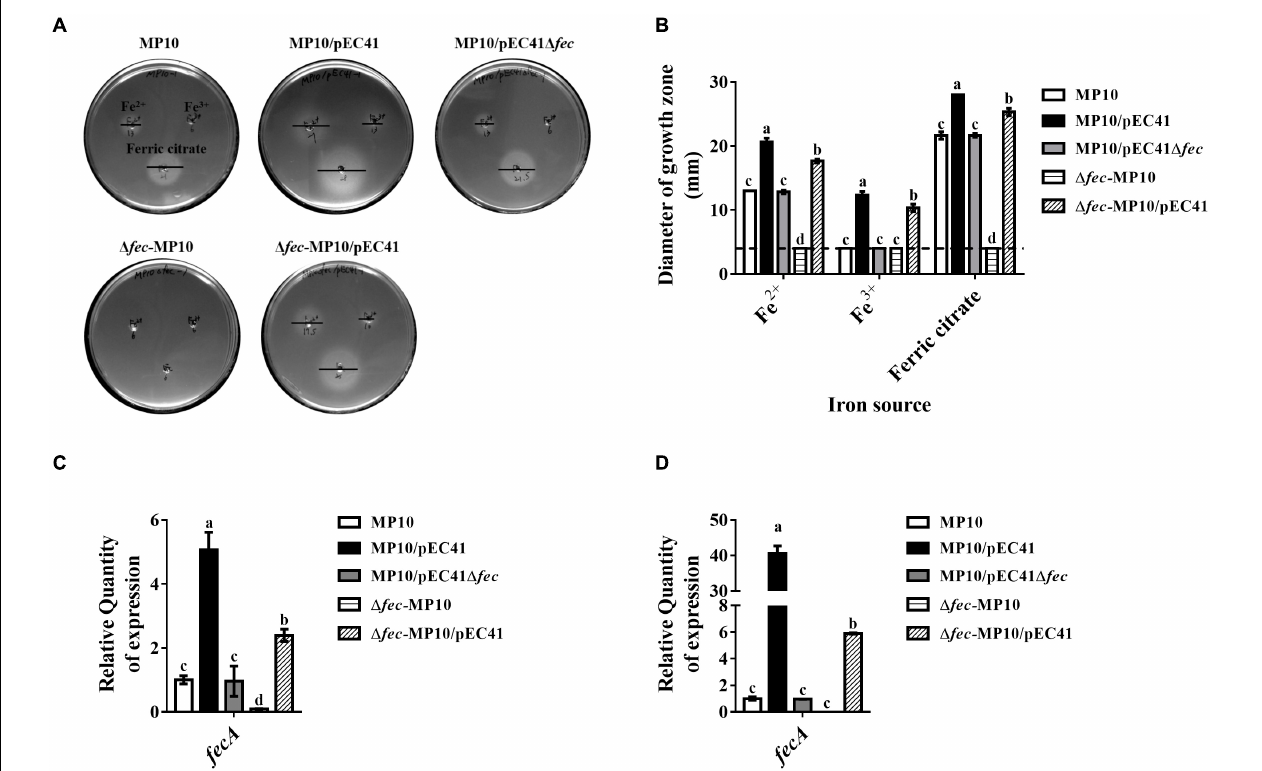
FIGURE 3 | The fec system of pEC41 provides iron uptake abilities. (A) Iron growth promotion assays of MP10 strains harboring pEC41 or pEC41 (cid:49) fec with and without the chromosomal deletion of fec MG1655 . ILM agar plates were seeded with the indicated strains, and three punched wells on each plate were loaded with 10 µ l of 10 mM ferrous sulfate (Fe 2 + ; top left panel), ferric chloride (Fe 3 + ; top right panel) and ferric citrate (bottom panel). The diameters of growth zones around the wells were determined after 24 h of incubation at 37 ◦ C. Bars indicated the diameters of the growth zones. (B) Quantification of the diameters of the growth zones of the strains in (A) . Dashed lines indicate the diameter of the wells (4 mm) of iron sources. (C,D) The mRNA levels of fecA in strains grown under iron-limited conditions without or with supplementation with ferric citrate. The bacteria were grown in M9 medium containing 100 µ M DIP without (C) and with (D) supplementation of 20 µ M ferric citrate overnight at 37 ◦ C. Levels of the fecA transcript were determined with real-time PCR using primers able to recognize the fecA genes in fec pEC41 and fec MG1655 . The fecA transcript level in each strain was normalized to the ftsZ level and presented as the relative level compared to that of MP10. The experiments were performed in triplicate and presented as the means ± SD. Different letters marked above the bars indicate groups with significant differences ( P < 0.05, one-way